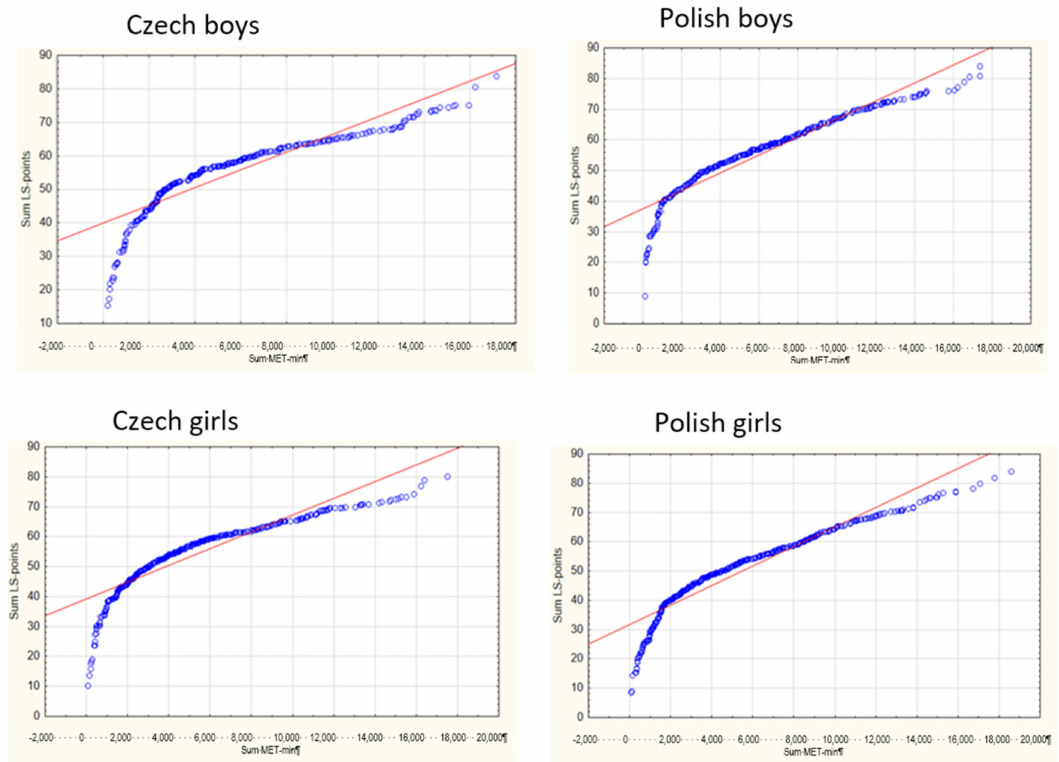
Figure 2. Association between life satisfaction (points) and total weekly physical activity (PA) (MET-min) among Czech and Polish boys and